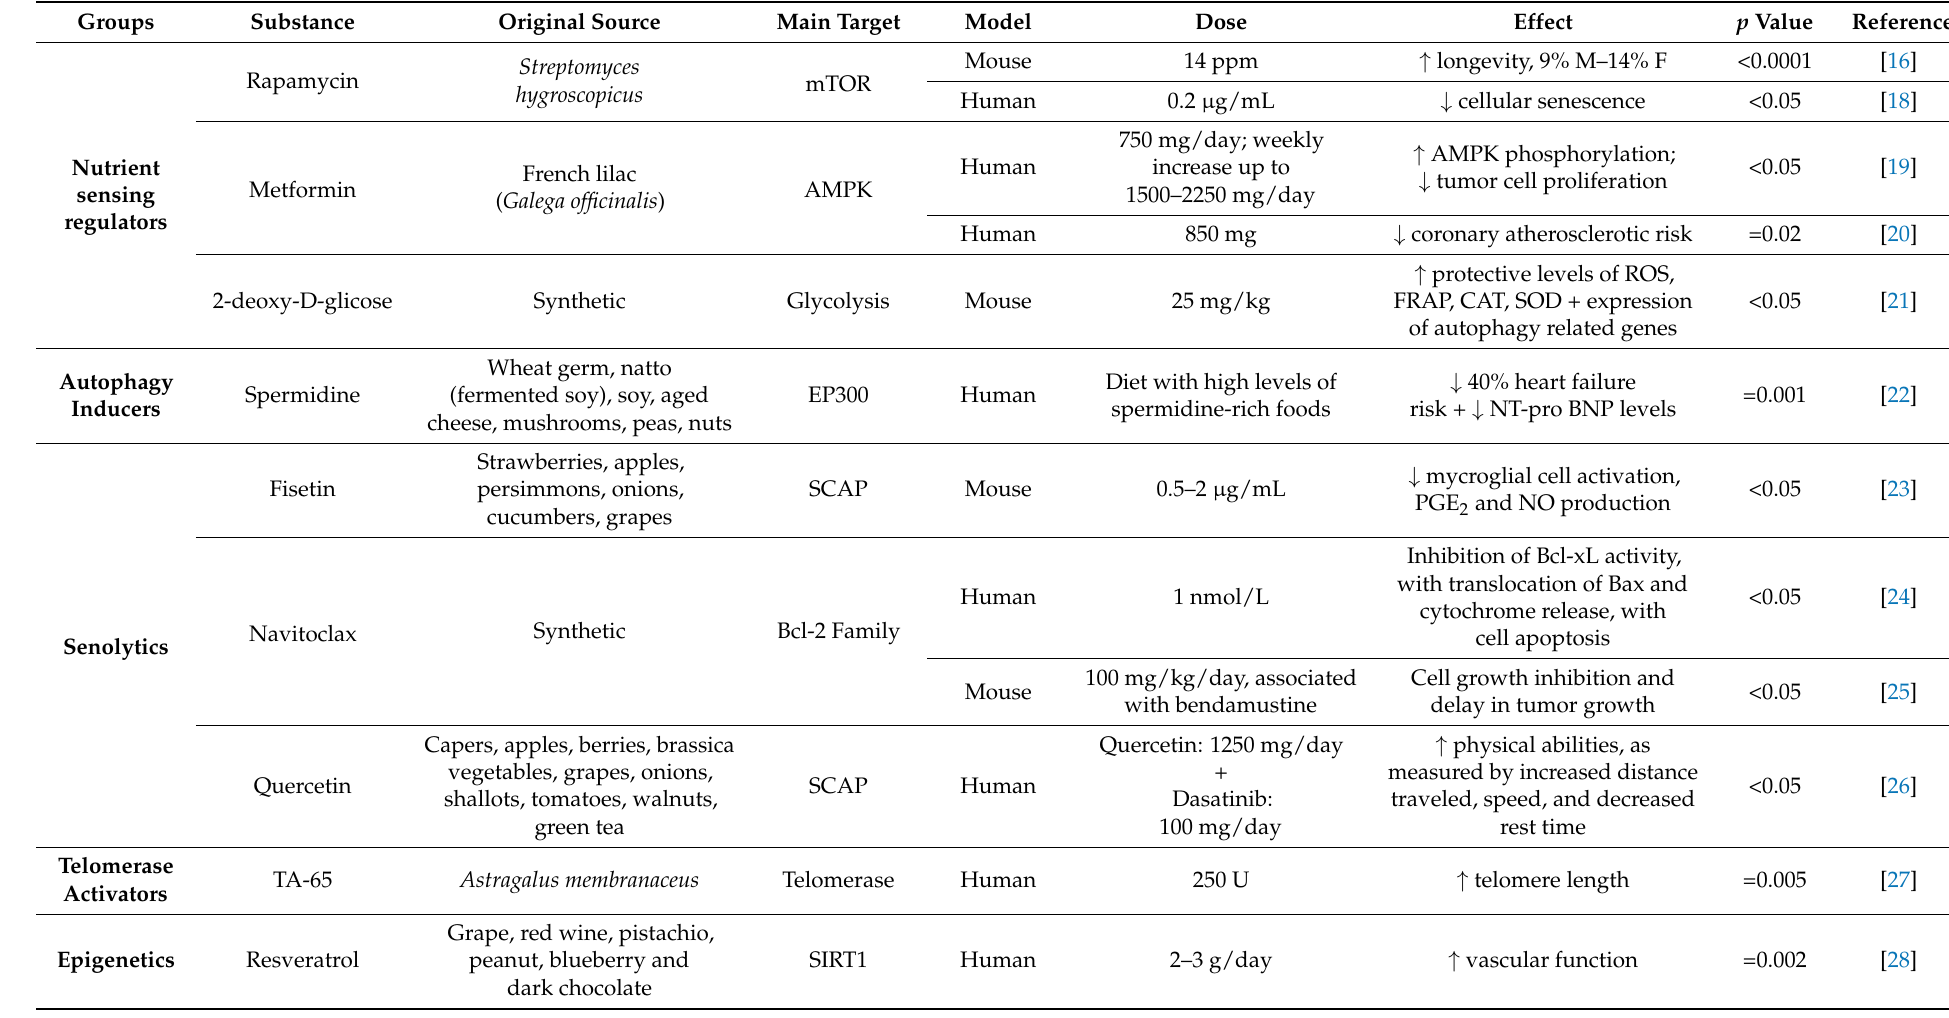
Table 1. Summary of the studies evaluated in terms of the anti-aging effects of the drugs and supplements